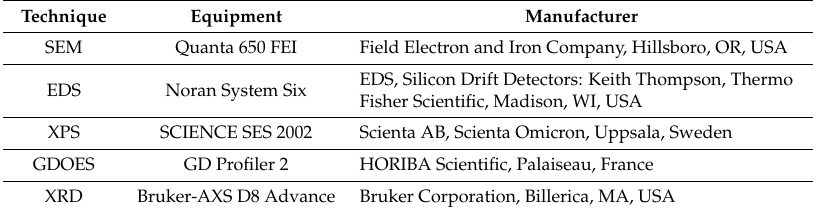
Table 3. Setups of SEM, energy dispersive spectroscopy (EDS), x-ray photoelectron spectroscopy (XPS), glow discharge optical emission spectroscopy (GDEOS), and XRD equipment.